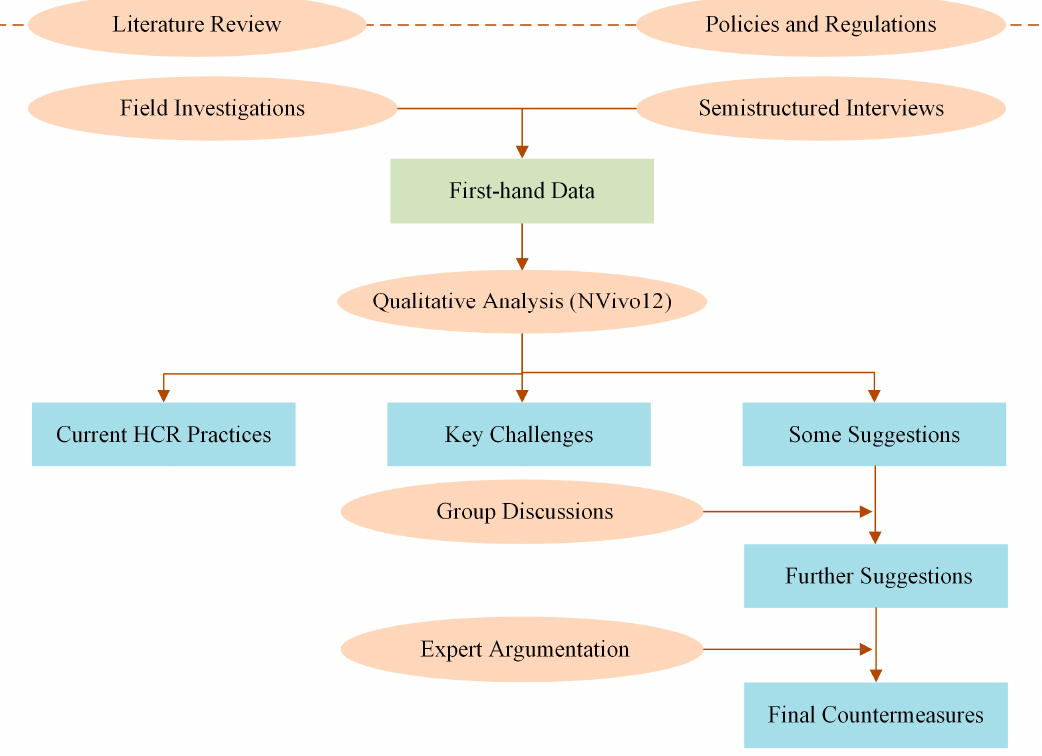
Figure 2. The mixed research method and process.